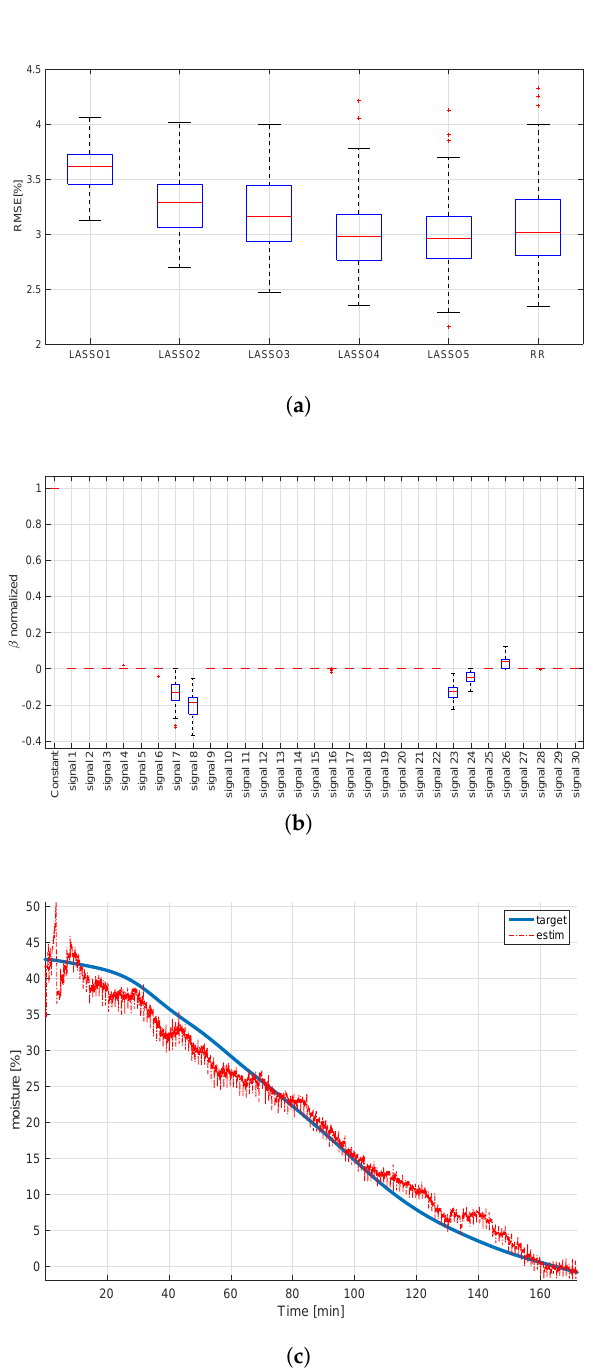
Figure 8. Examples of results using Method 1: ( a ) Performance in terms of RMSE distribution (in % moisture content) using regularized linear models; the size of input signals increases from left to right. ( b ) Variable selection made by the LASSO imposing the use of few predictors (LASSO1) for each iteration. The term Constant on x-axis is the intercept of the linear models for which coefficients are represented here. ( c ) Example of laundry moisture content estimation using all predictors (RR); on y-axis, the moisture content in